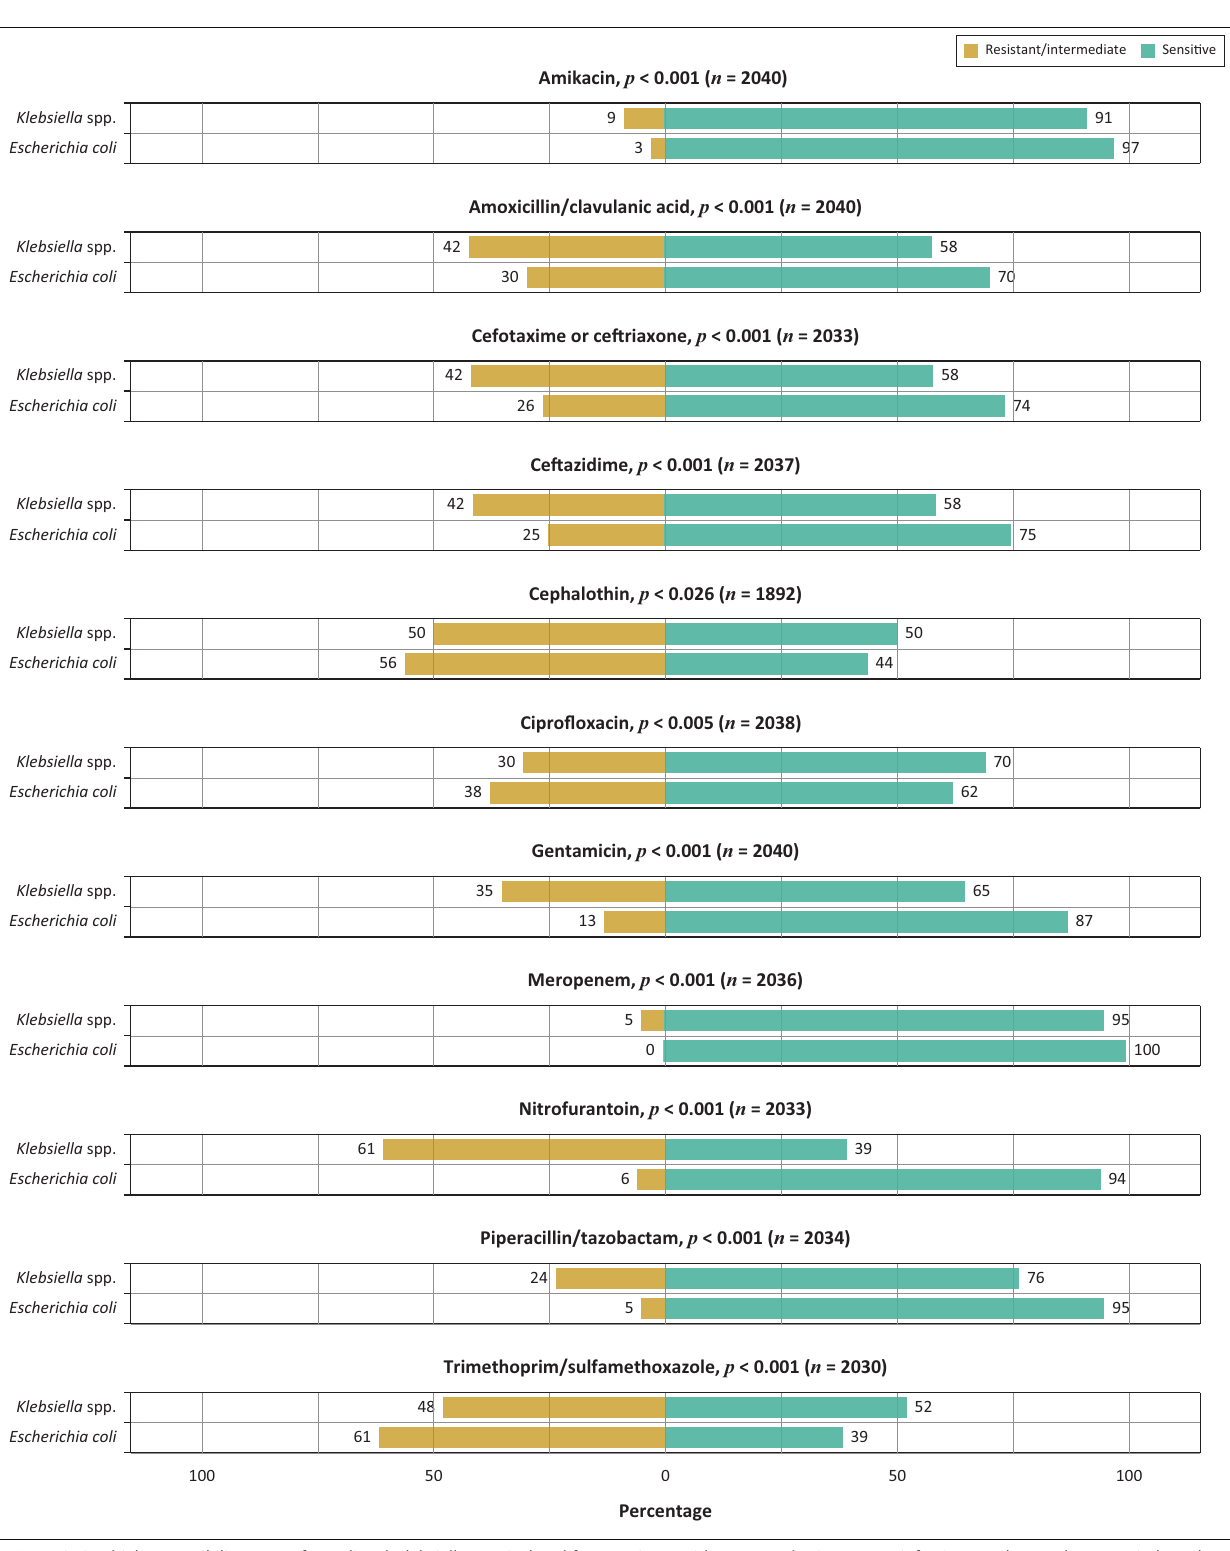
FIGURE 2: Antimicrobial susceptibility rates of E. coli and Klebsiella spp. isolated from patients with suspected urinary tract infections at the RK Khan Hospital, Durban, KwaZulu-Natal, South Africa, January 2018 – December 2020. The total number of isolates is different for each antimicrobial due to missing results linked to random terminations that can sometimes occur during automated antimicrobial susceptibility testing with the VITEK ® 2